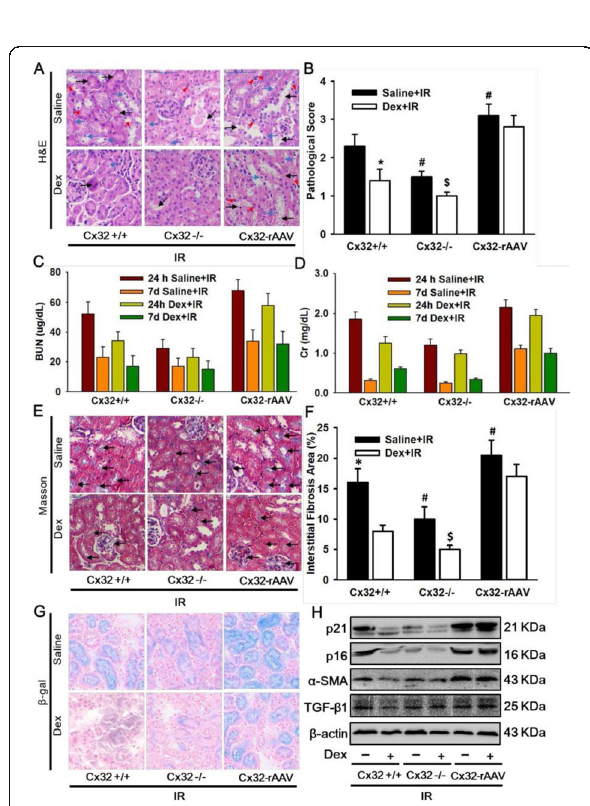
Fig. 3 (abstract 000565). Dexmedetomidine Protected against HR-induced senescence-associated fibrosis by Inhibiting Cx32